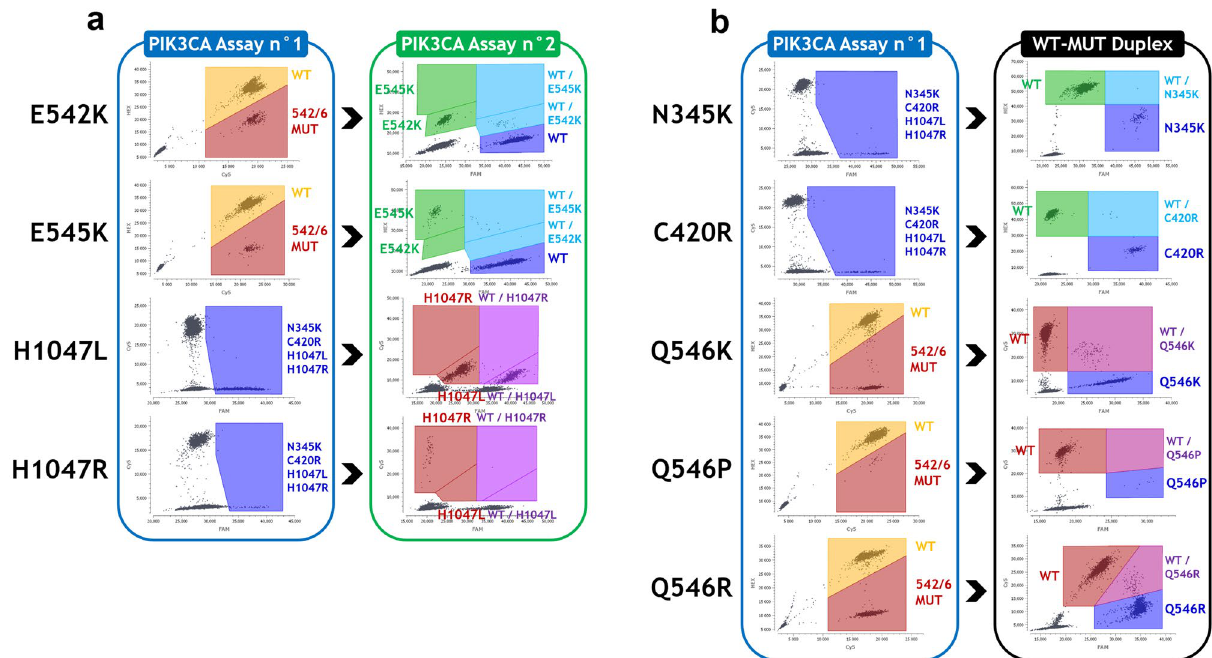
Figure 5. Examples of PIK3CA mutations identified on patient cfDNA samples with the PIK3CA assays and WT-MUT duplexes. ( a ) 2D dot plot results of the four most frequent PIK3CA mutations (E542K, E545K, H1047L and H1047R), first detected using the PIK3CA Assay n°1 with the respective MAF of 16.86%, 4.17%, 17.13% and 1.97%, and confirmed using the PIK3CA Assay n°2 with the respective MAF of 17.40%, 5.25%, 19.55% and 1.97%. ( b ) 2D dot plot results of the other mutations (N345K, C420R, Q546K, Q546P and Q546R), first detected using the PIK3CA Assay n°1 with the respective MAF of 4.00%, 3.83%, 35.02%, 1.12% and 39.62%, and confirmed using the WT-MUT duplexes with the respective MAF of 6.99%, 6.50%, 36.84%, 0.71% and